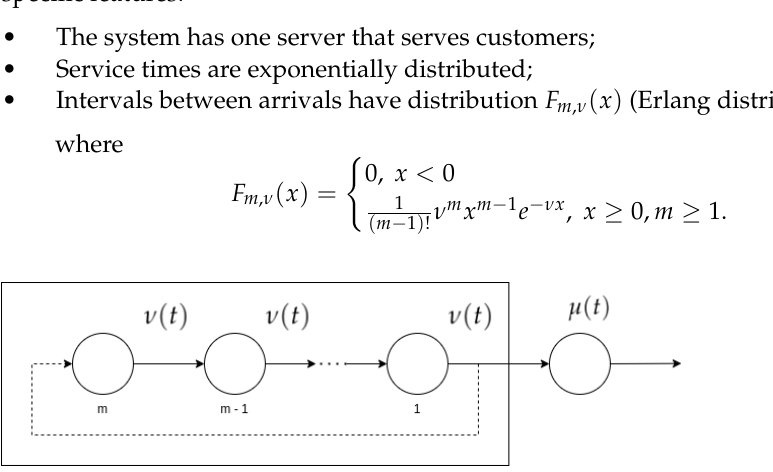
Figure 1. Transition graph for the PH / M /1